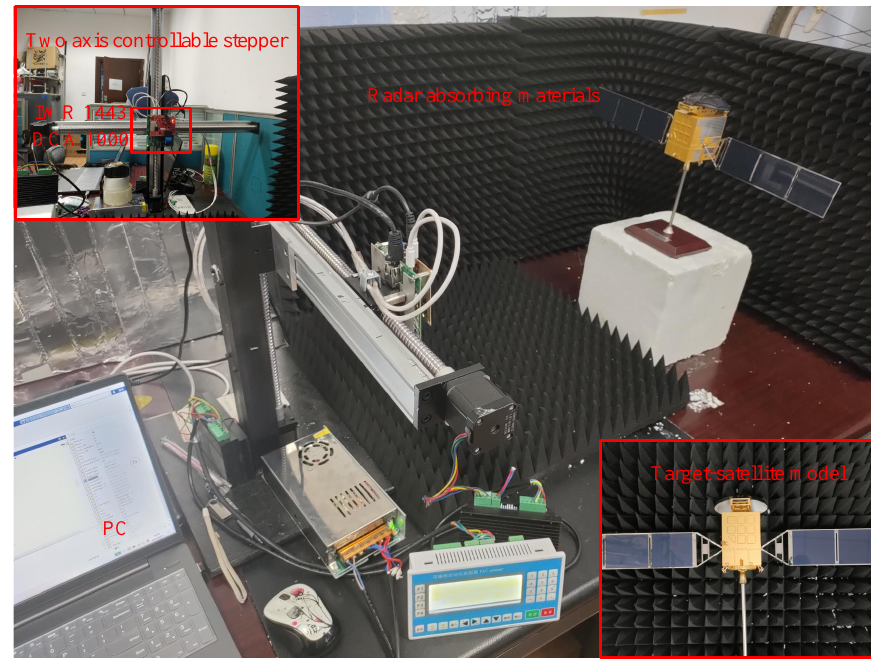
Figure 5. The experimental equipment of data acquisition